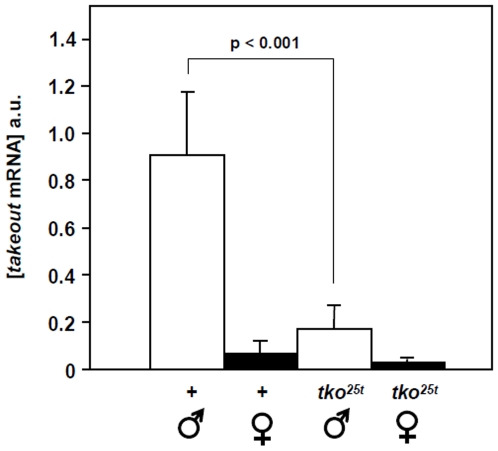
Quantitative RT-PCR verification of transcriptomic data on takeout.RNA measurements were made and normalized as described in Materials and Methods. Means±SD of three sample runs of each of three biological replicates are shown. Significance at the p value shown was computed using a t-test. See also Table 3.